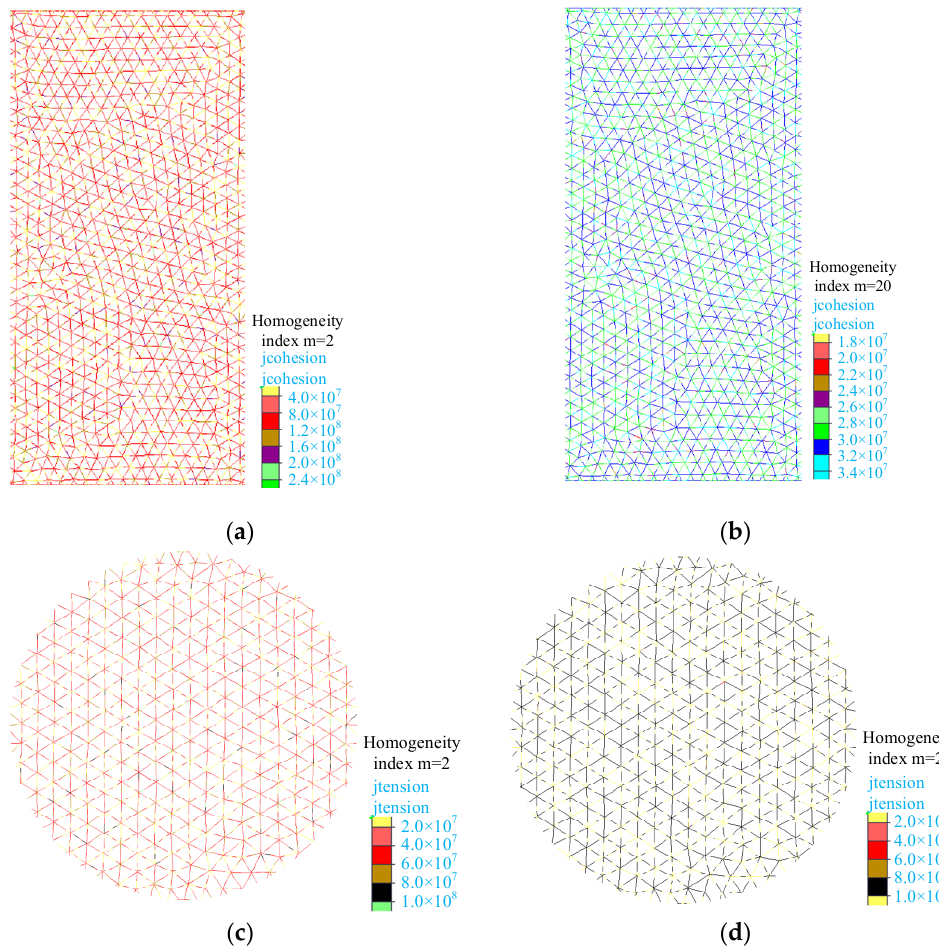
Figure 2. Contact cohesion and contact tensile strength distributions after calibration: ( a ) contact cohesion distributions under the confining pressure of 2.5 × 10 6 Pa when the homogeneity index is 2; ( b ) contact cohesion distributions under the confining pressure of 2.5 × 10 6 Pa when the homogeneity index is 20; ( c ) contact tension strength distributions under the Brazilian test simulation when the homogeneity index is 2; ( d ) contact tension strength distributions under the Brazilian test simulation when the homogeneity index is 20.